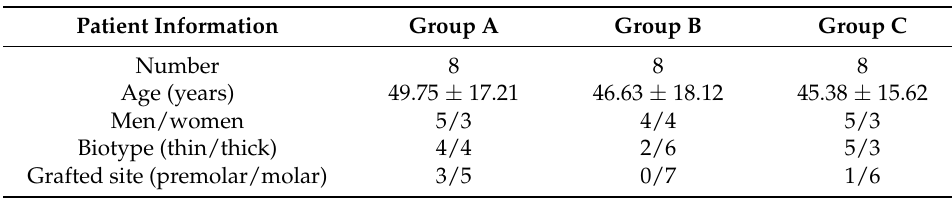
Table 1. Demographic data of